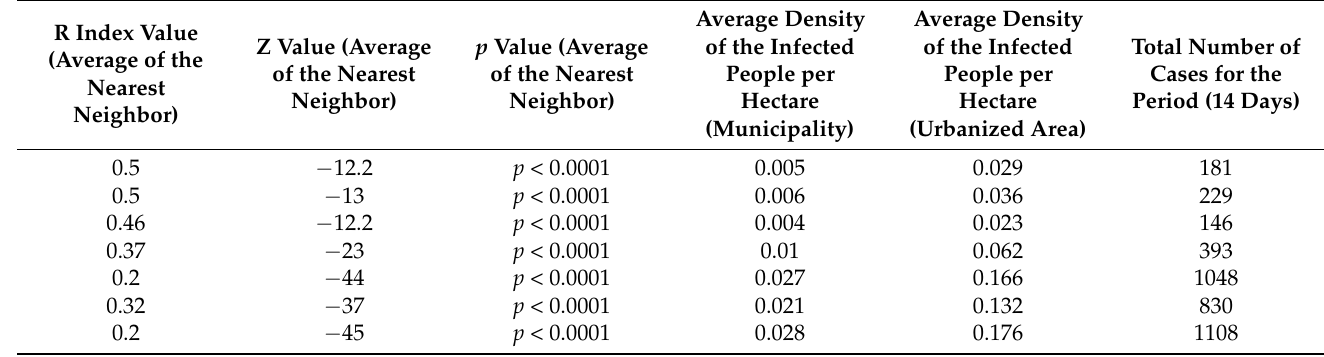
Table 2. Concentration values of the infected according to the closest average method in the different periods analyzed, and the general parameters of the epidemics’ incidence in each